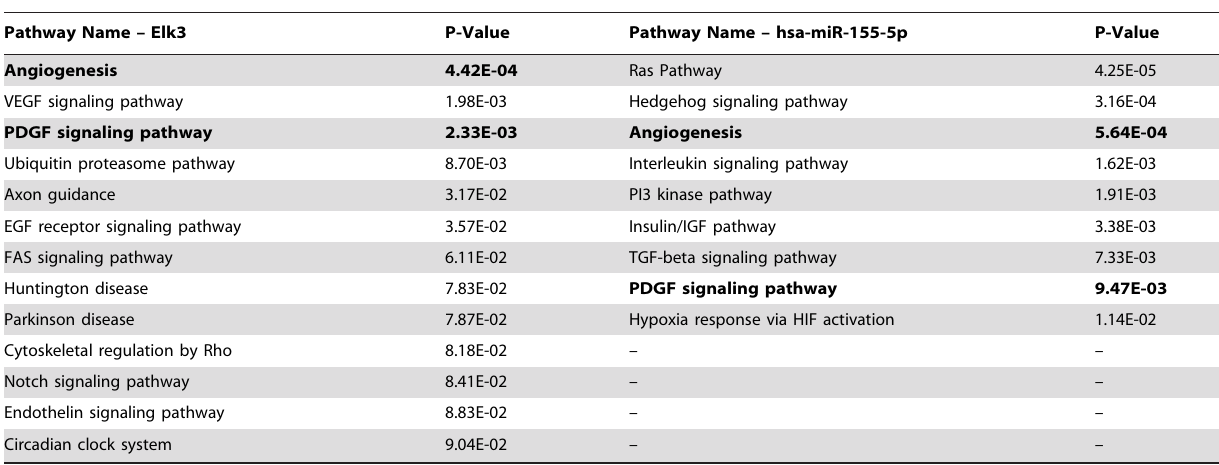
Table 2. Elk3/hsa-miR-155-5p PANTHER pathway